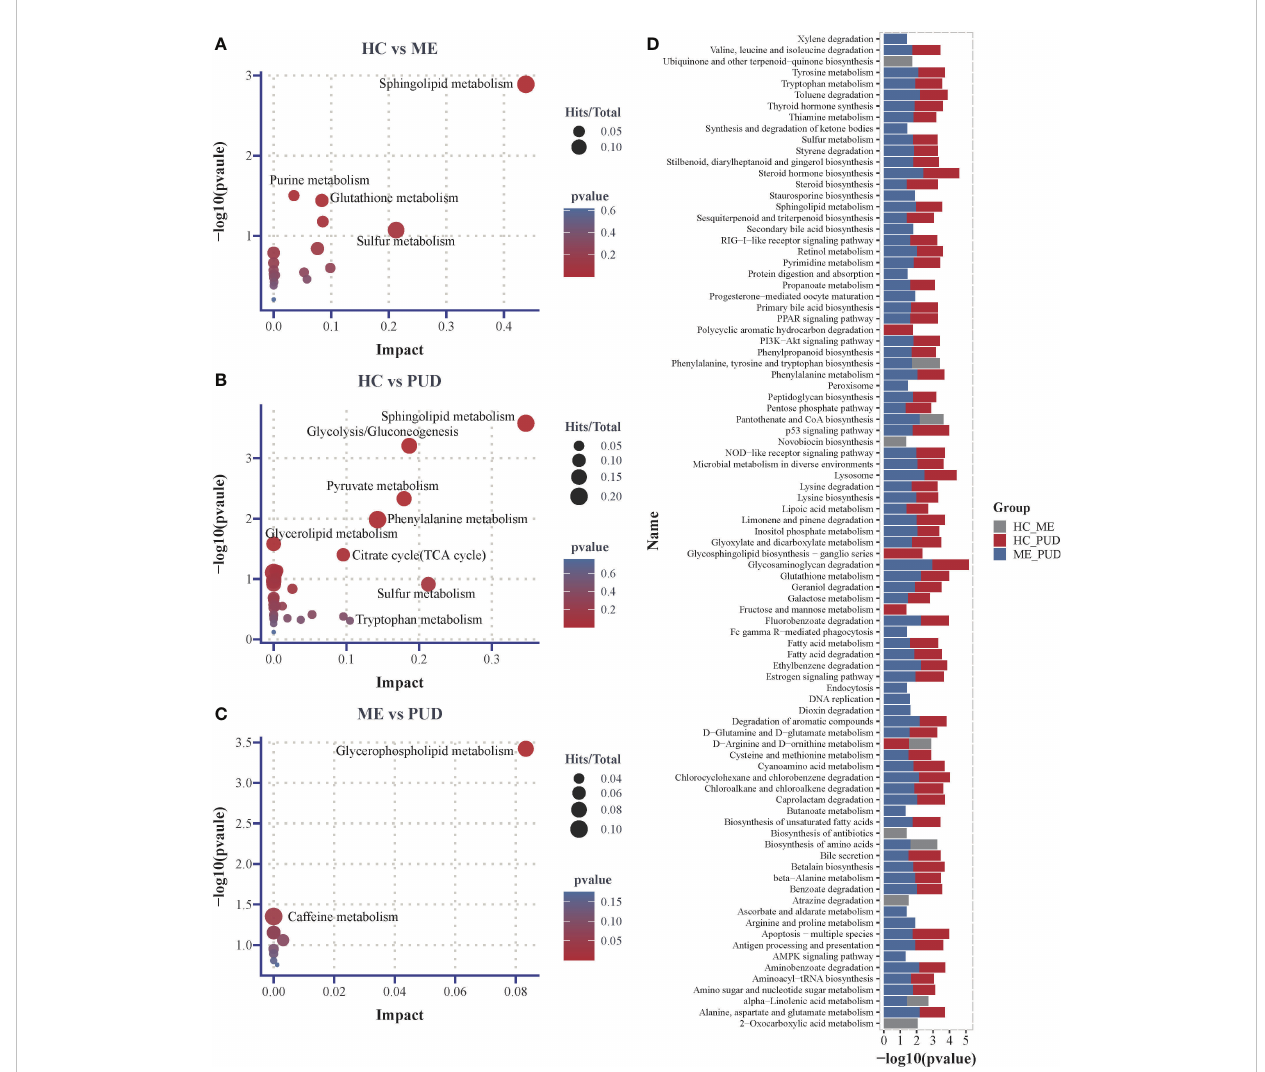
FIGURE 7 Differential metabolic pathways. (A) , the plot of differential metabolic pathways of HC vs. ME; (B) , the plot of differential metabolic pathways of HC vs. PUD; (C) , the plot of differential metabolic pathways of ME vs. PUD; (D) , the histogram of predicted metabolic pathways of the fl ora based on PICRUSt2 and KEGG database. Impact, the value of weight calculation based on topological analysis; larger Impact, more signi fi cant Pathway; Total, total number of metabolites in the target metabolic pathway; Hits, number of differential metabolites in the target metabolic pathway; p-value, hypergeometric distribution